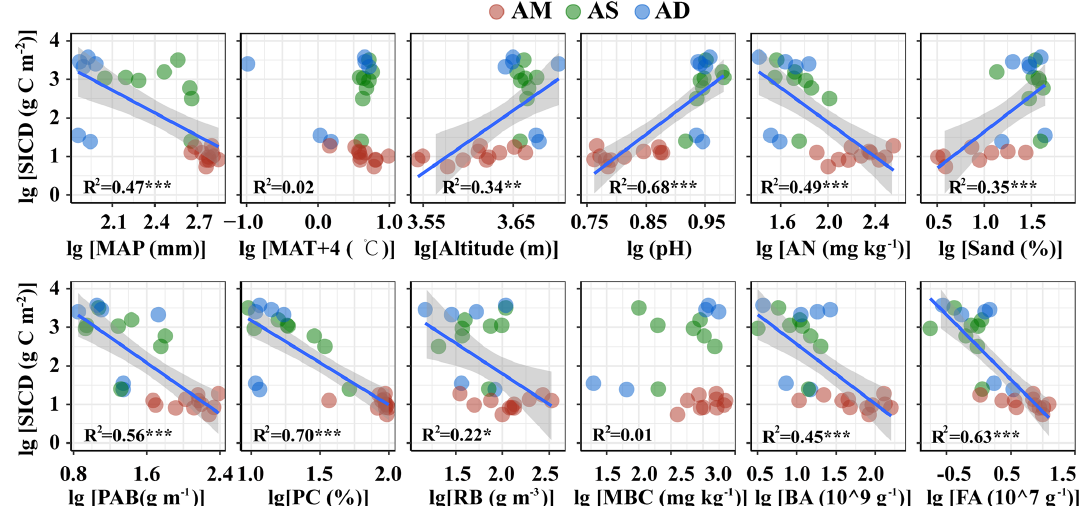
Figure 3. SIC density in relation to climatic, edaphic, plant and microbial factors in the subsoil. The solid lines are fitted by ordinary least- squares regressions, and the shadow areas correspond to 95% confidence intervals. AM: alpine meadow; AS: alpine steppe; AD: alpine